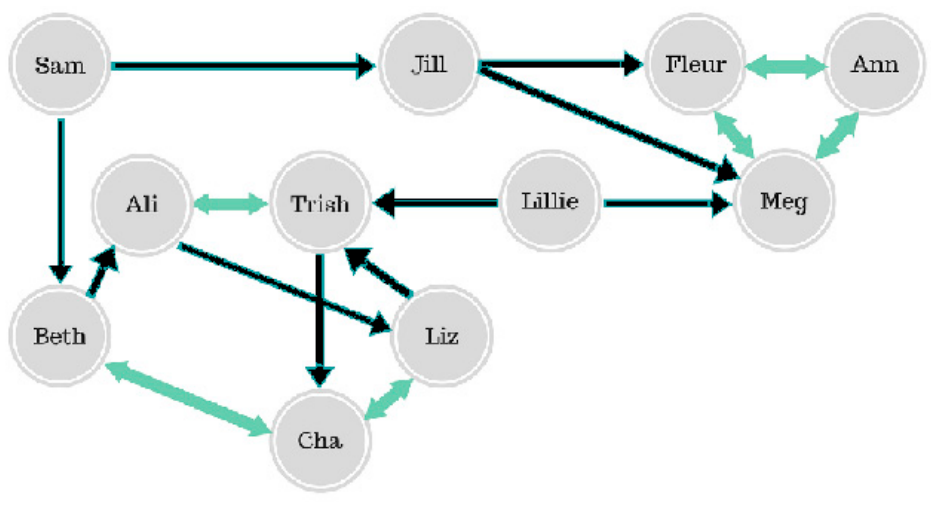
Figure 7. Relationship guideline.